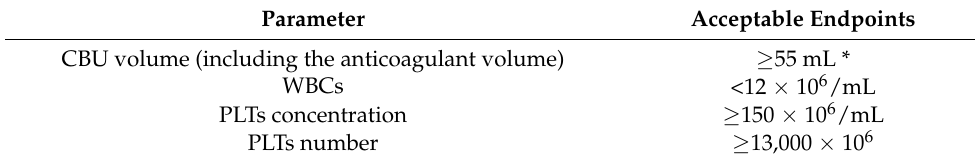
Table 1. Acceptance criteria of CBUs prior to CBPG processing.